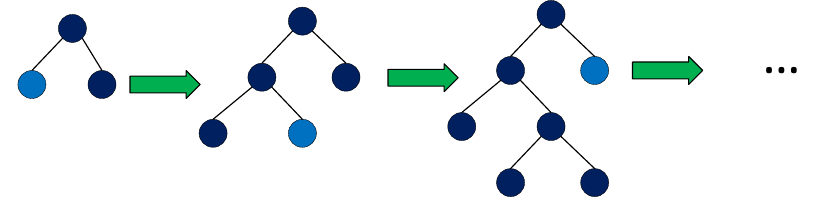
Figure 2. Leaf-wise tree growth in LightGBM [19].